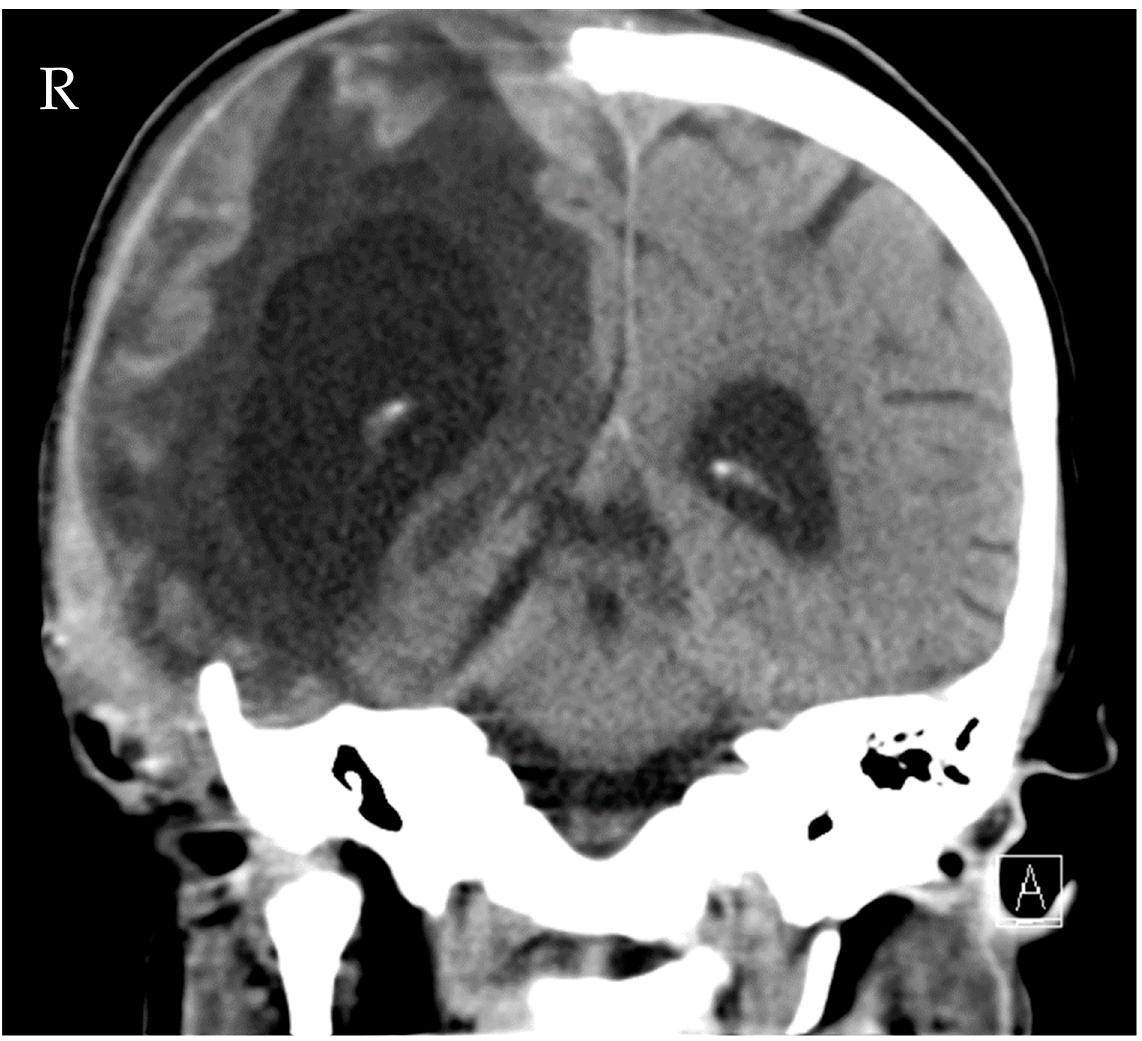
Figure 4. Computed tomography of the head showing distinctive hydrocephalus with pronounced enlargement of the ventricular system (malresorptivus and e-vacuo components).